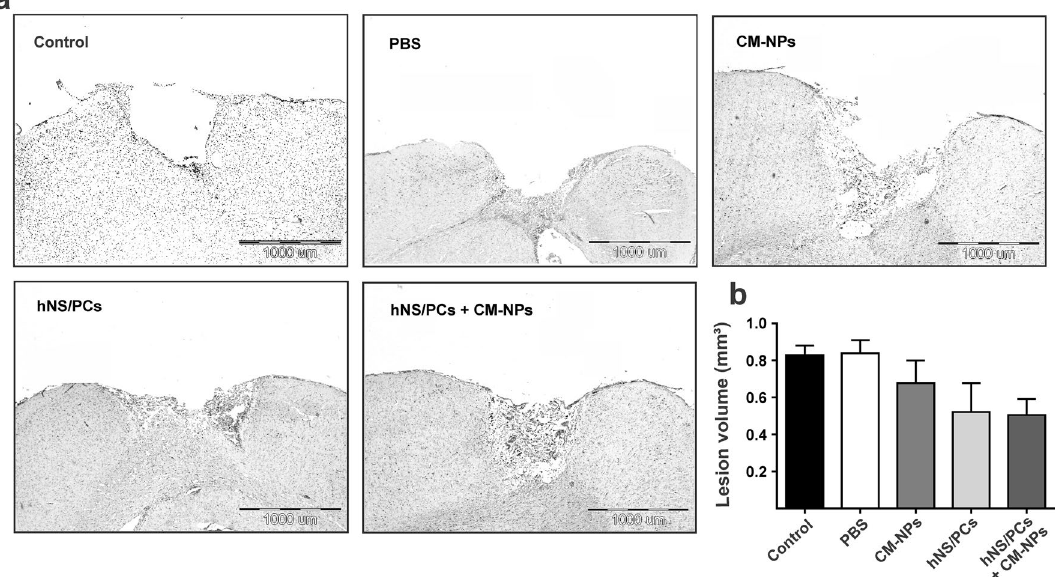
Figure 5. The mean lesion volume at the injury site after TBI in different groups. ( a ) Lesion areas are stained by hematoxylin–eosin (HE) in different groups. ( b ) The bar graph indicates the lesion volume in different experimental groups on day 28 after TBI. Data represented as lesion volume mean ± SEM (n =